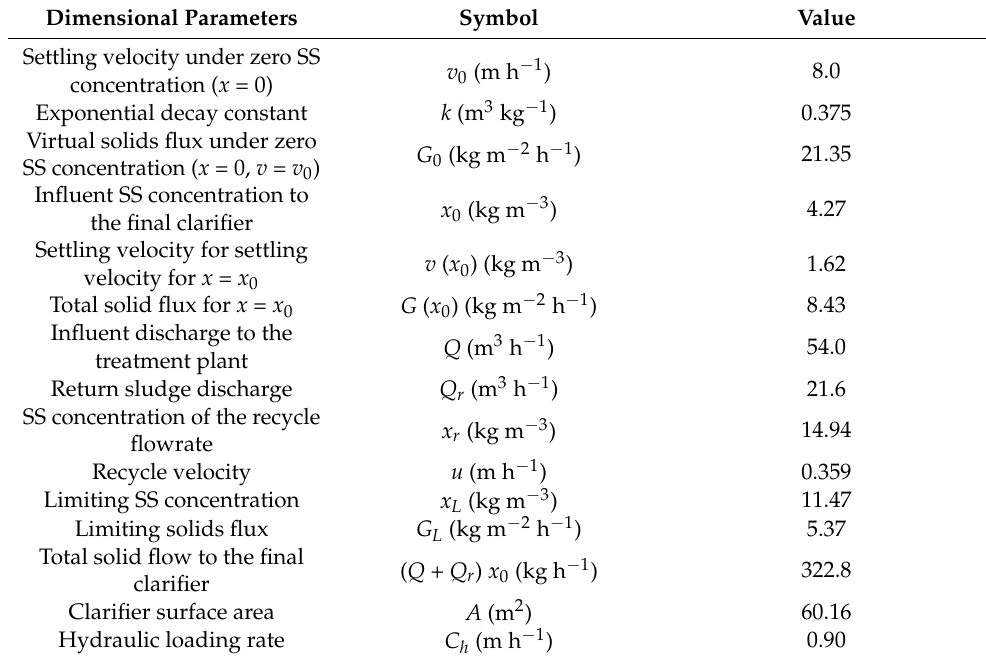
Table 2. Dimensional parameters and their symbols and values, corresponding to the application of Figure